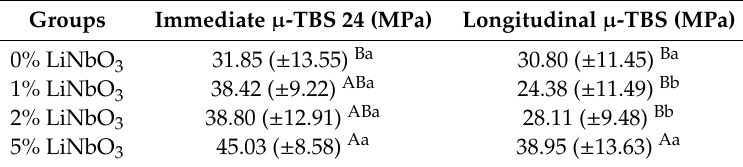
Table 2. The results of the immediate and longitudinal microtensile bond strength ( μ -TBS) of the experimental adhesives expressed in the mean and standard deviation for each group.